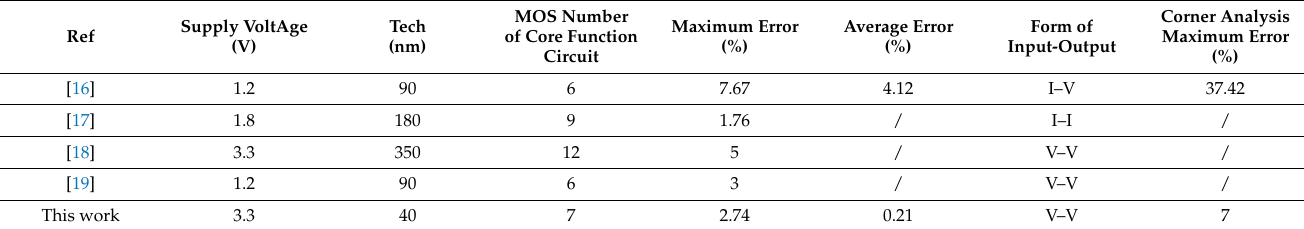
Table 2. Comparison of this work and former works.